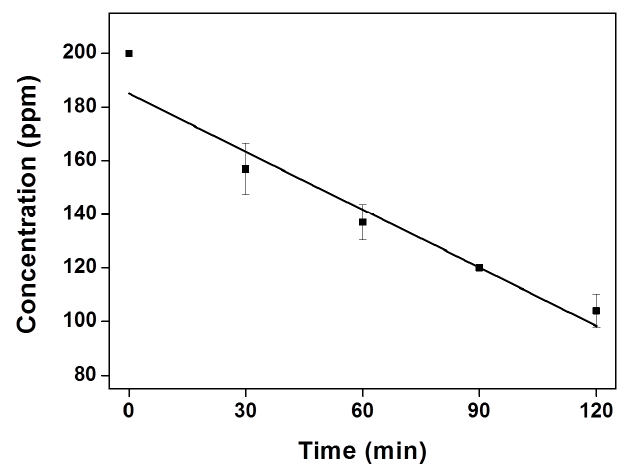
Figure 8. Photocatalytic degradation of phenol in the presence of the 400 nm PS-patterned TiO 2 film.